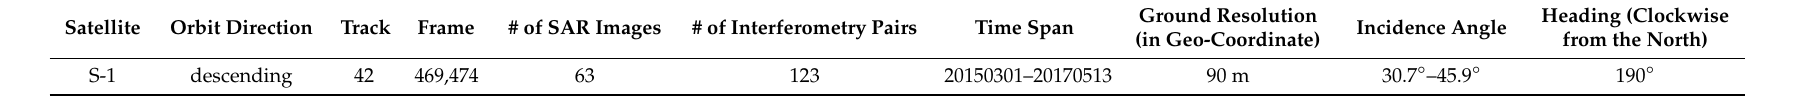
Table 1. Sentinel-1 data used in the